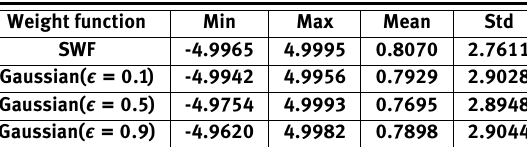
Fig. 9. Std of the differences between SMLS approximated values and those from shipborne gravimetry, as a function of δ , SWF and Gaussian weight functions, ϵ = 0.1, 16 harmonic basis functions